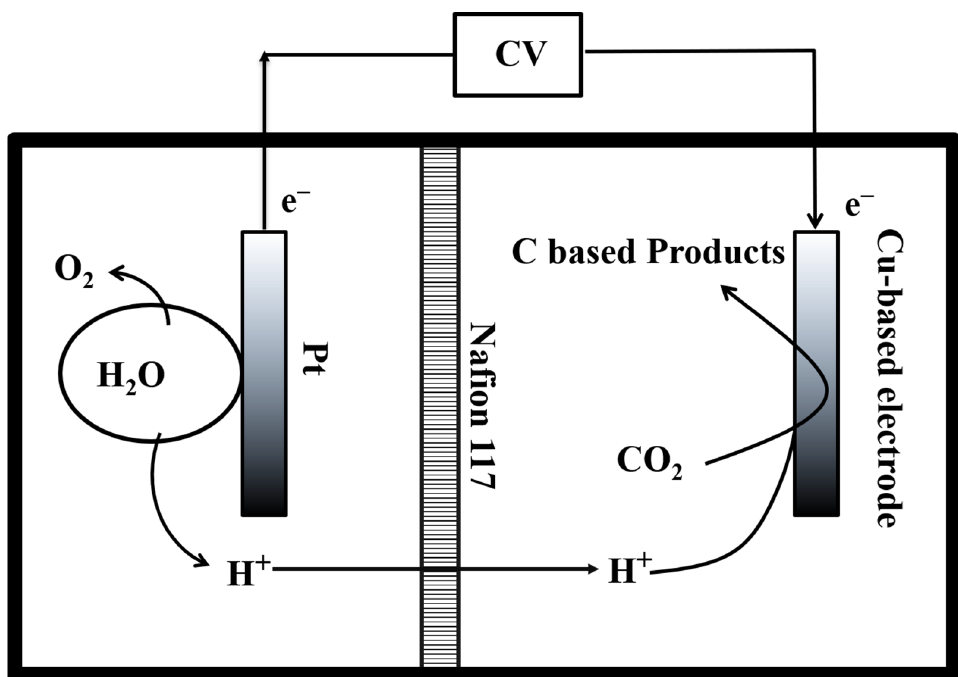
Figure 17. The scheme of CO 2 RR system for Cu-based electrodes.